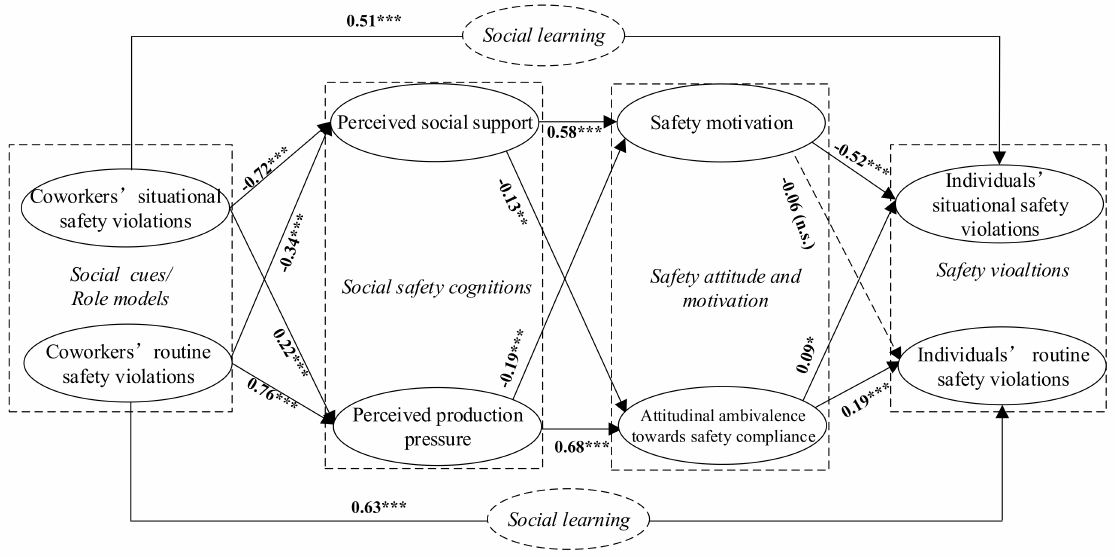
Figure 3. The estimated structural model for total sample of workers ( χ 2 TLI = 0.960; IFI = 0.966; RMSEA = 0.049). Note. *** p < 0.001, ** p < 0.01, * p < 0.05, n.s. p >